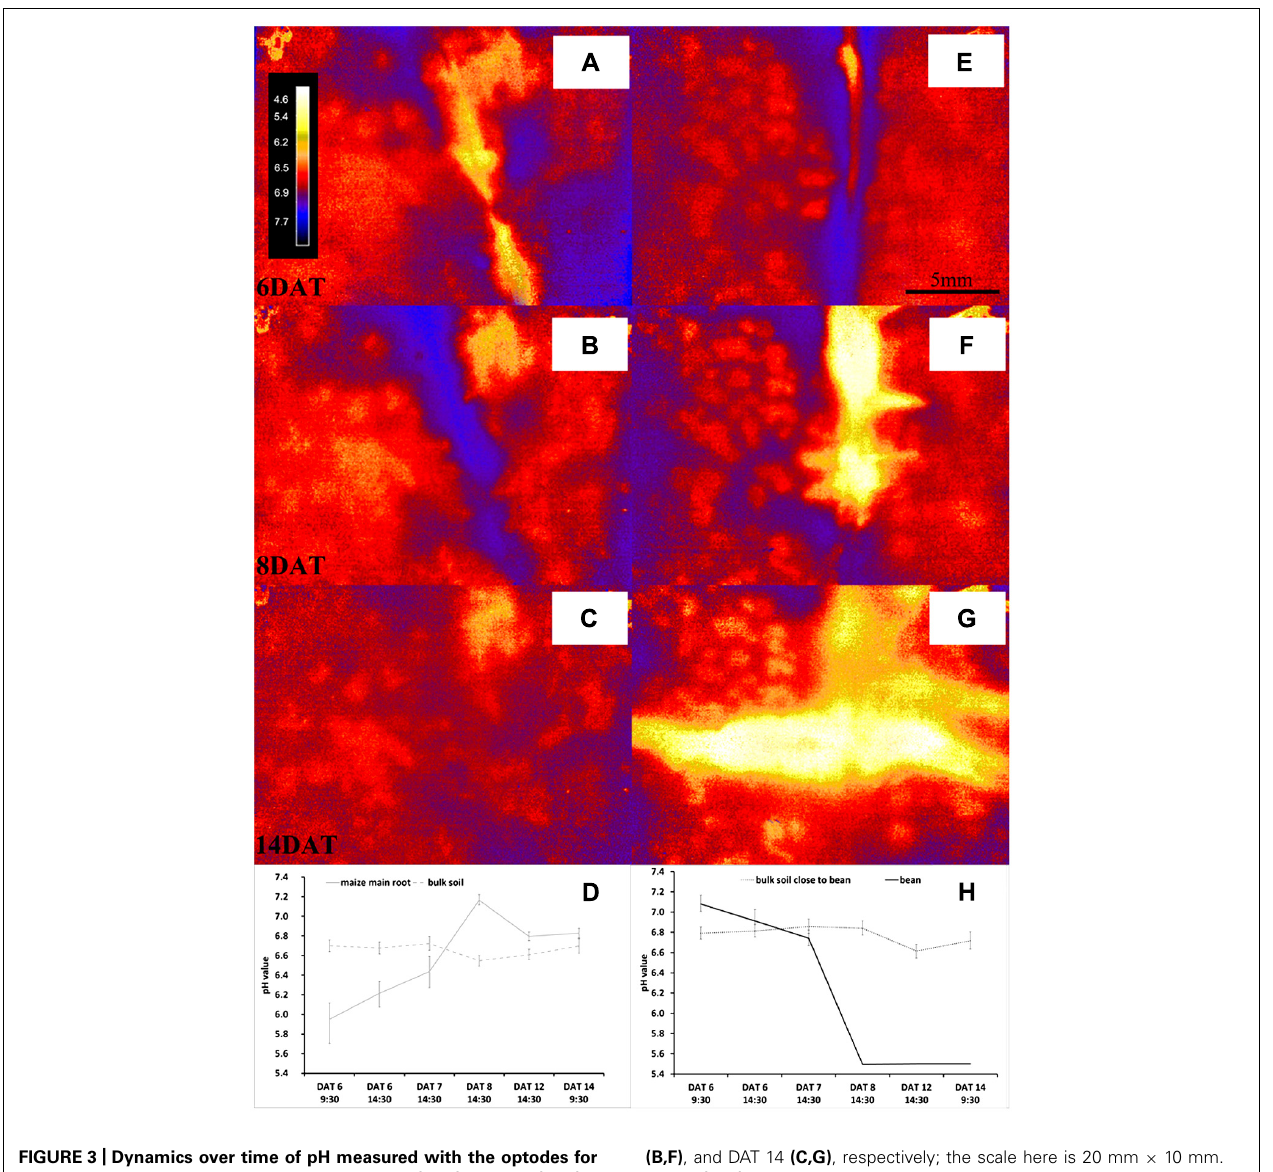
FIGURE 3 | Dynamics over time of pH measured with the optodes for the rhizosphere and bulk soil of roots of maize (A–D) or bean (E–H) growing alone . Panels (A–C,E–G) show the pH maps of the respective ROIs at a scale ranging from 4.6 to 7.7 pH units at DAT 6 (A,E) , DAT 8